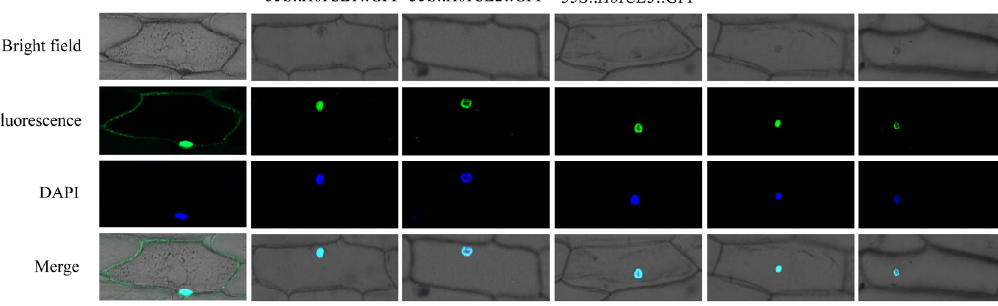
Figure 2. Subcellular localization of HbICEs.